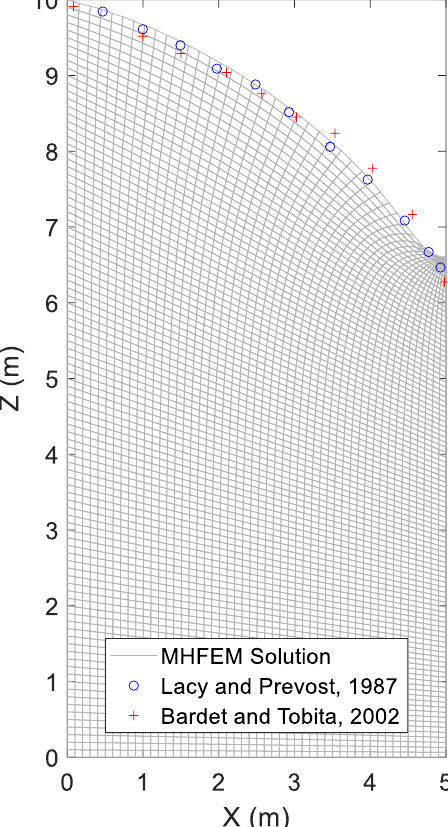
Figure 7. Simulated steady-state water table position using the adaptive mesh MHFEM technique for the third test problem. All horizontal lines of the two-dimensional mesh were allowed to move during the iterative procedure. The water table is favorably compared with numerical solutions provided by other authors [55,56].